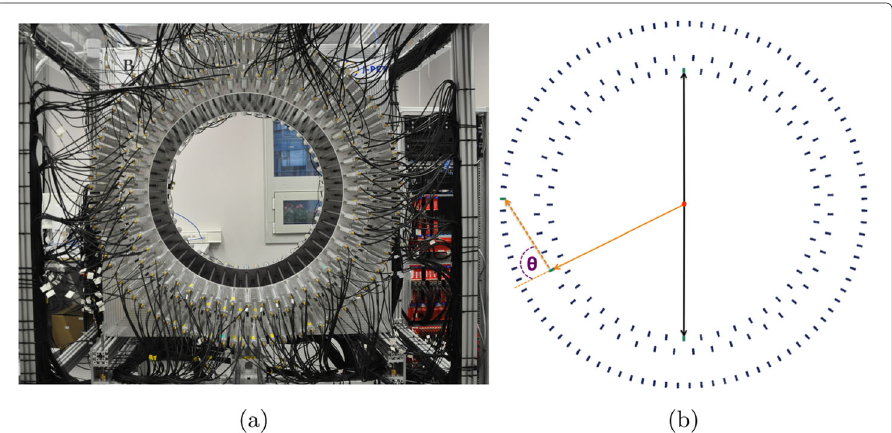
Fig. 1 a The photo of J-PET scanner with the front view (see text for description). b The cross section of J-PET with superimposed arrows depicting the interaction of 511 keV photons (black solid arrows) originating from positron-electron annihilation and prompt photon 1275 keV before (orange solid arrow) and after (orange dashed arrow) scattering inside the scintillator. Red dot in the center represents the 22 Na source